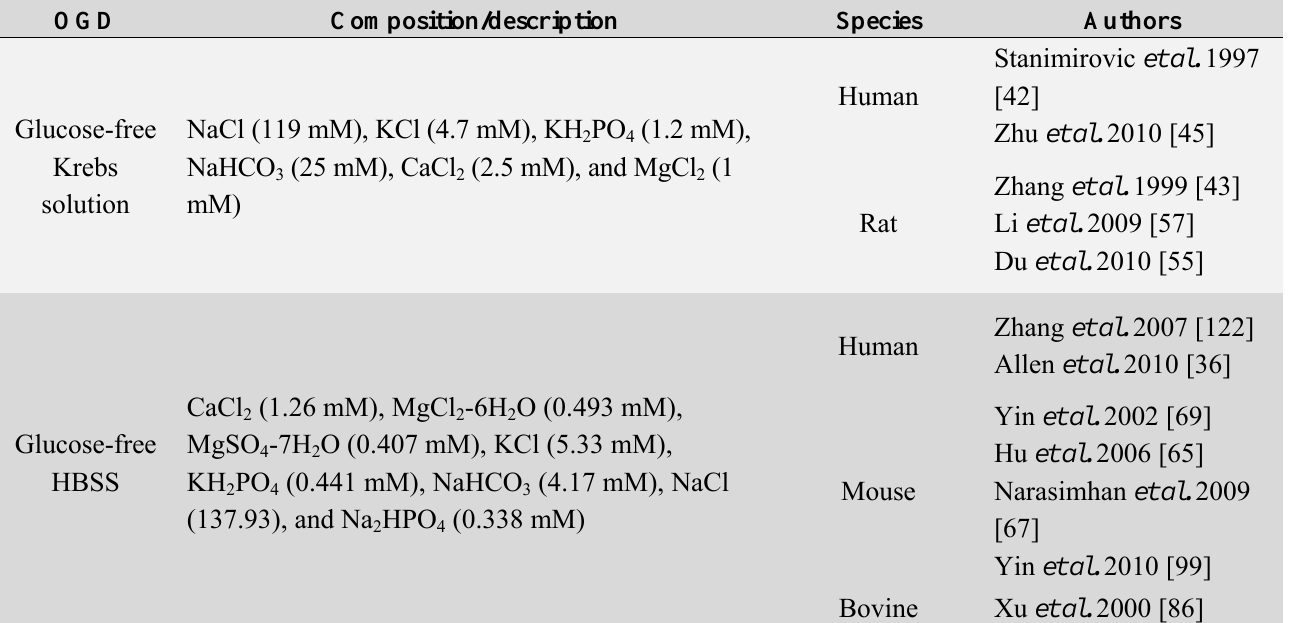
Table 5. Composition of the different media used in the different studies performed with brain endothelial cells submitted to